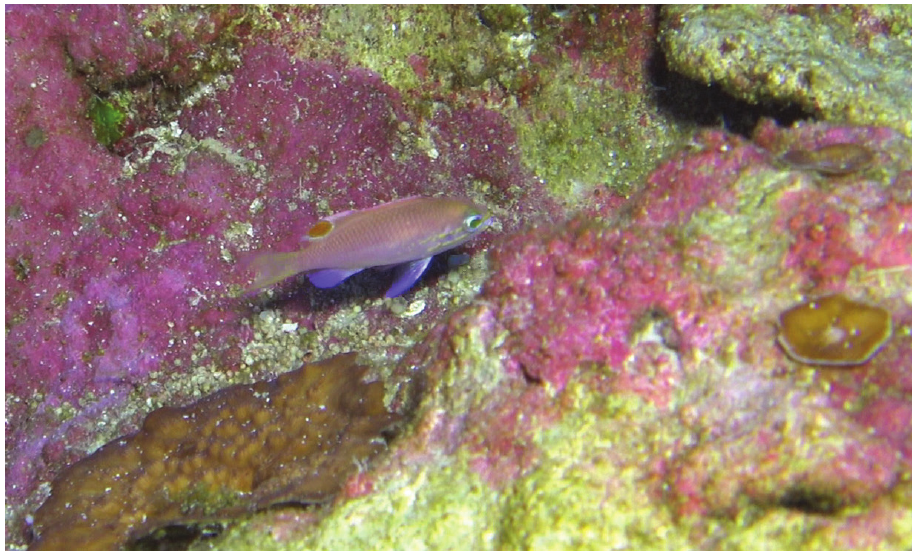
Figure 3. Holotype of Tosanoides obama immediately prior to collection, at a depth of 90 m off Kure Atoll, Northwestern Hawaiian Islands. Cropped frame from video by R. L. Pyle.